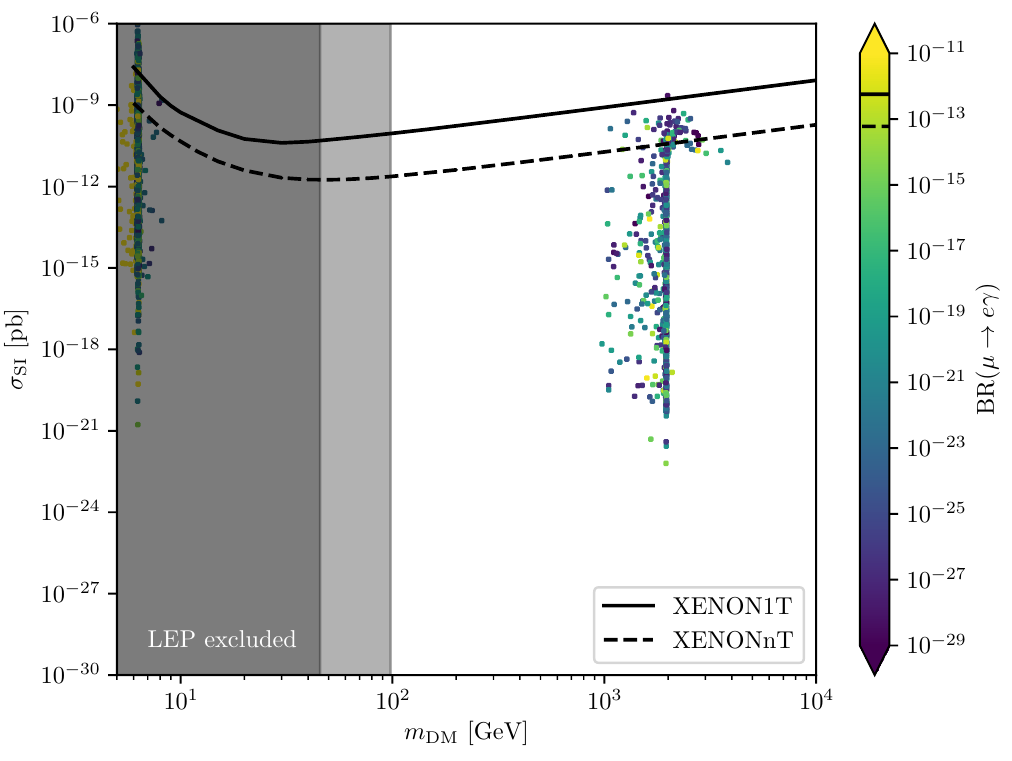
Figure 10 . The spin-independent direct detection cross section as a function of the DM mass for triplet scalar DM. The colours show the branching ratios for the LFV process (cid:22) e(cid:13) . Also shown ! are the LEP limits on light neutral and charged particles (shaded areas) as well as current (full lines) and future (dashed lines) exclusion limits for the DM relic density from XENON1T [36] and XENONnT [39, 40], and for (cid:22) e(cid:13) [41, !